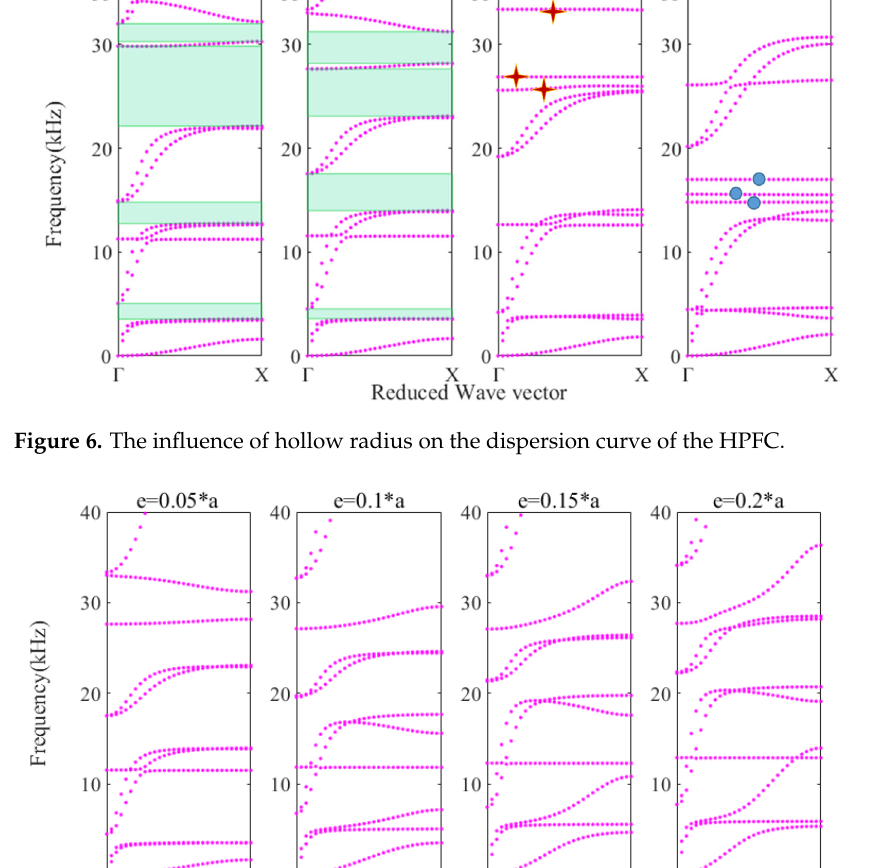
Figure 6. The influence of hollow radius on the dispersion curve of the HPFC.